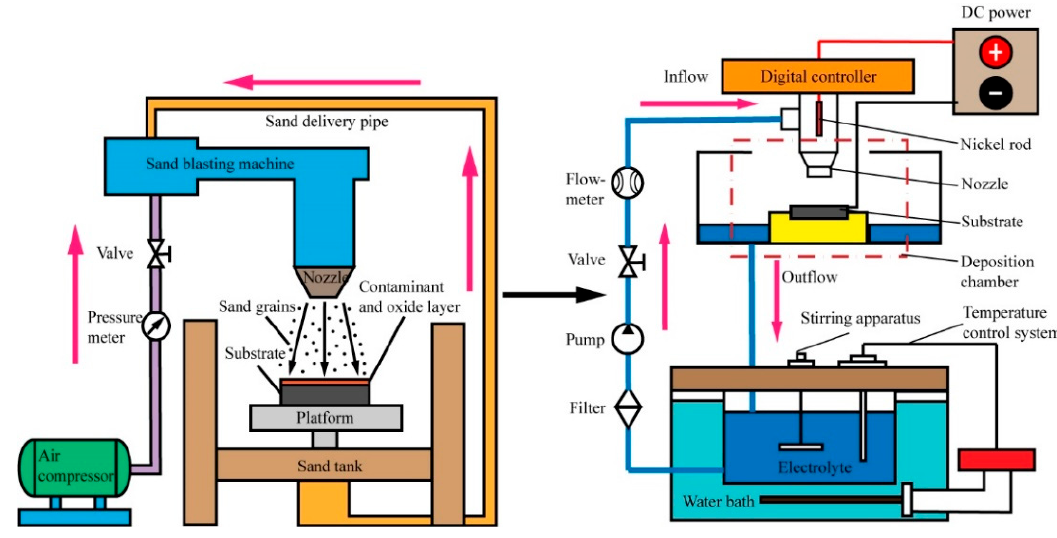
Figure 1. Experimental process diagram.